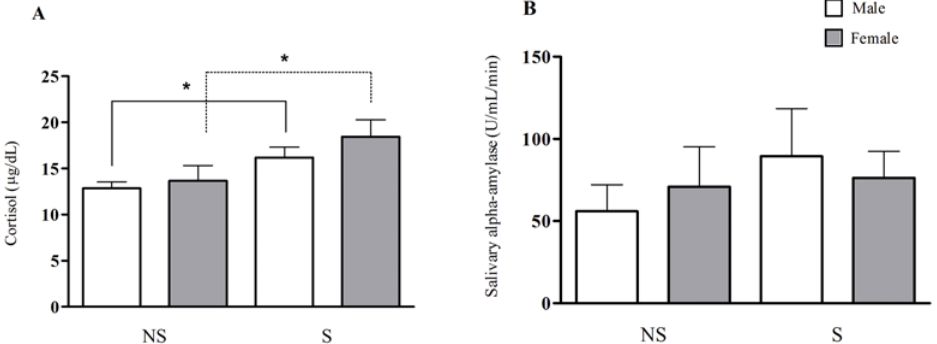
Fig 2. Biological variables in non-stressed (NS) and stressed (S) subjects. A. Serum cortisol in non- stressed and stressed male and female subjects at rest. B. Salivary alpha-amylase activity prior to the cognitive task in non-stressed and stressed male and female groups. ( * ) Indicates significant differences, p (cid:1) 0.05 (One-way